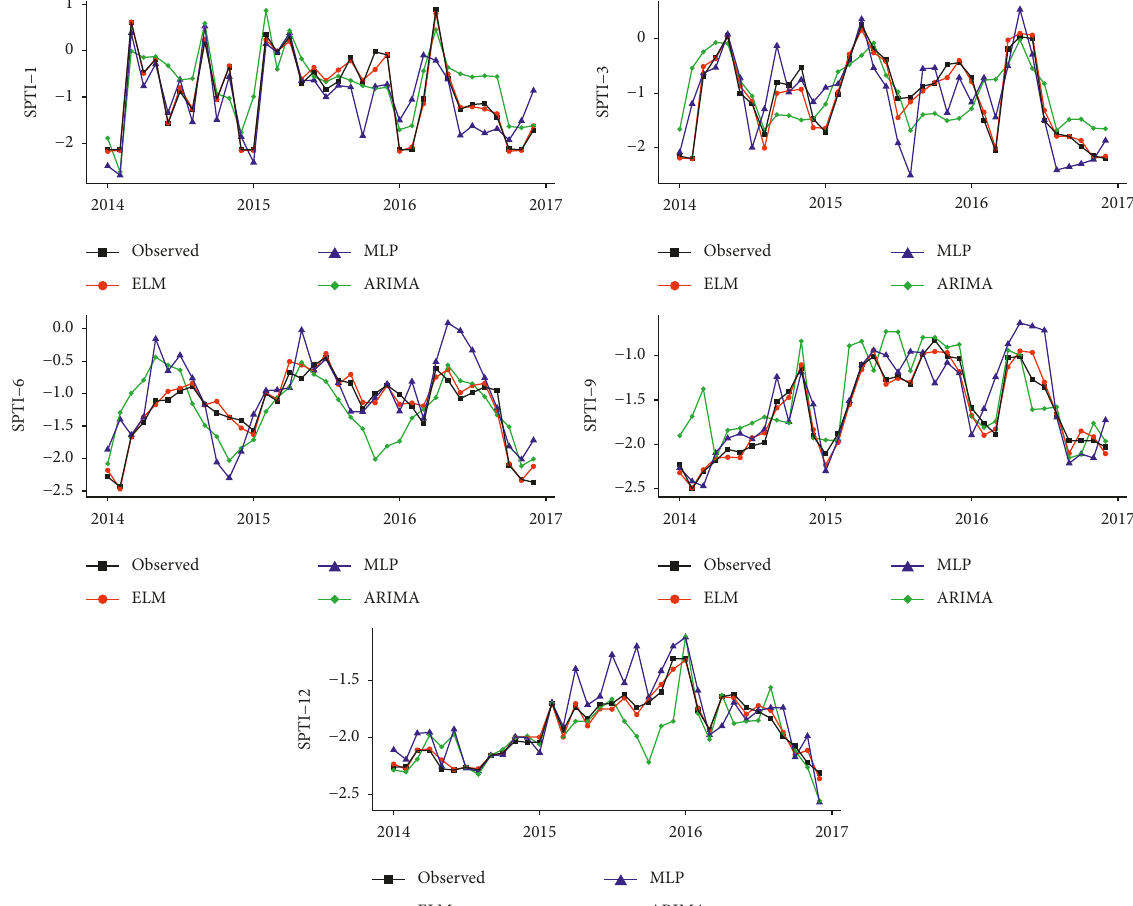
Figure 13: Observed and forecasted SPTI by ELM, MLP, and ARIMA models at Astore station for 1, 3, 6, 9, and 12 month lead time